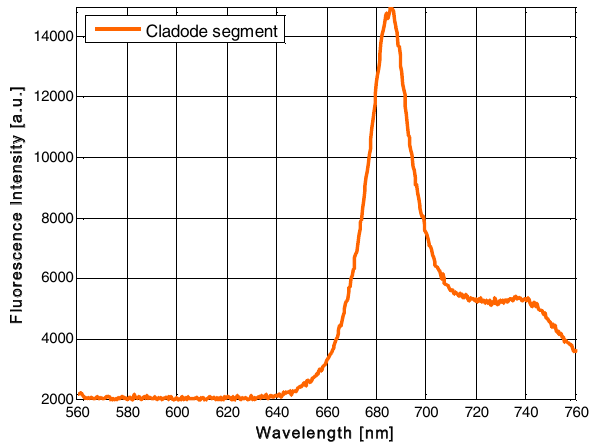
Figure 4. Fluorescence emission spectrum of the cladode portion on which the different cochineals were placed for spectra measurements in Fig. 1a.